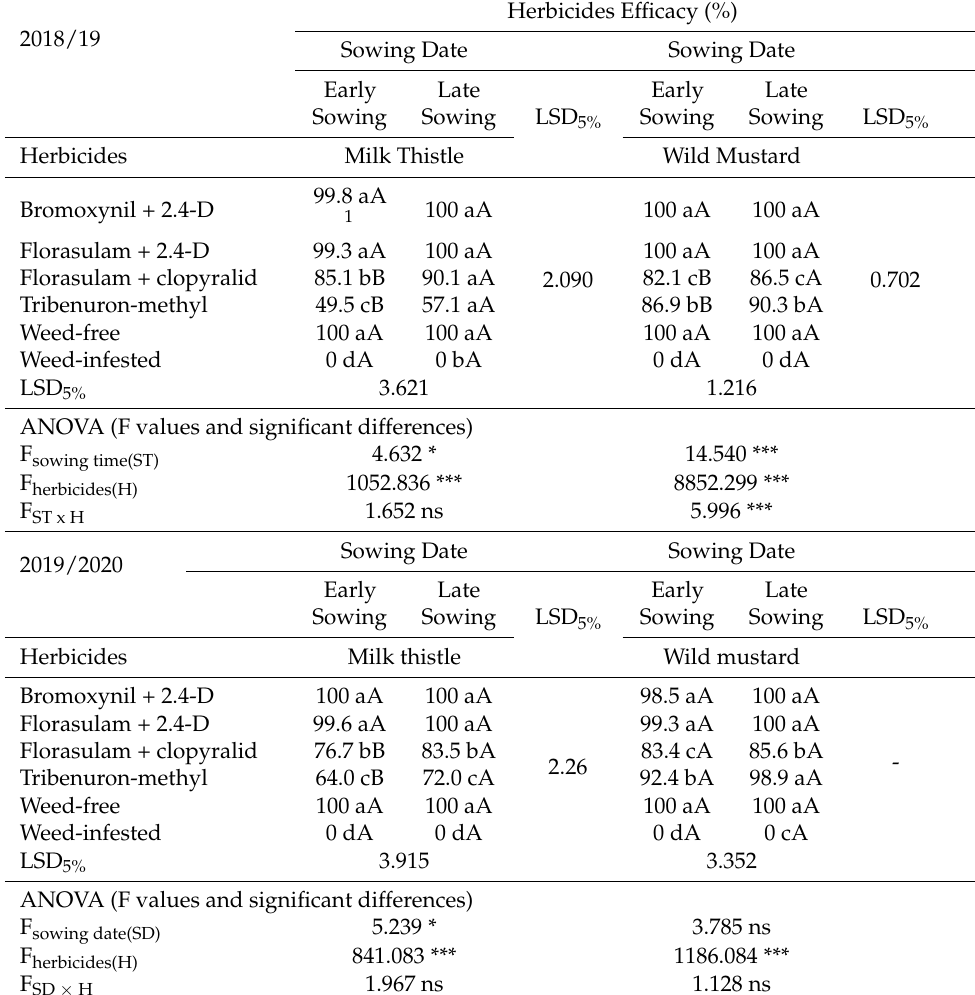
Table 4. Herbicides’ efficacy as affected by the sowing date (early and late sowing) and the herbicide treatments (bromoxynil + 2.4-D, florasulam + 2.4-D, florasulam + clopyralid, tribenuron-methyl, weed-free, and